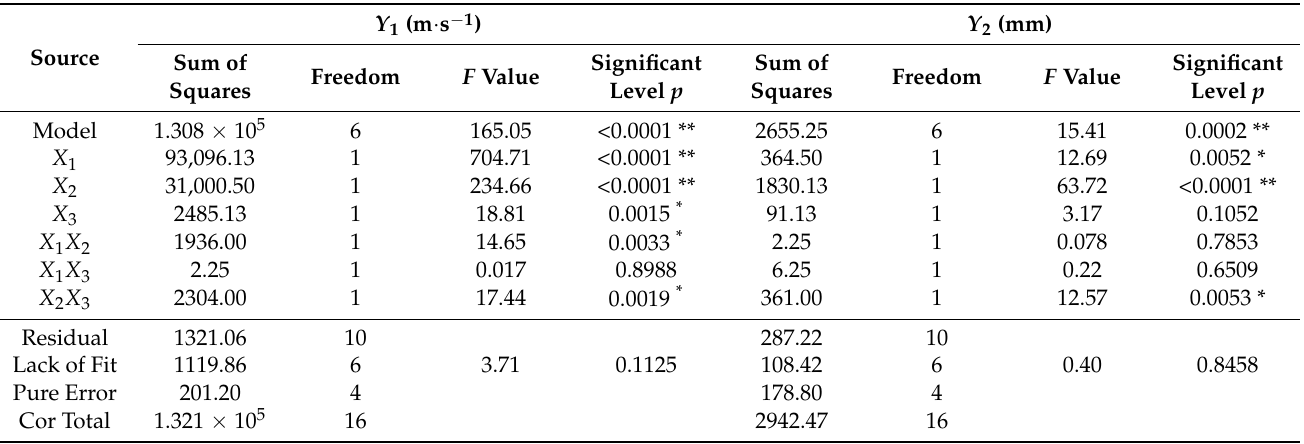
Table 4. Variance analysis of 2FI regression